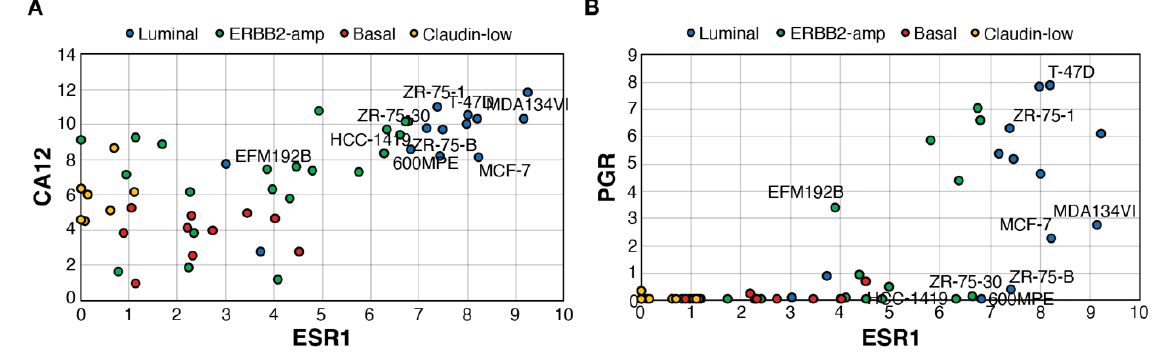
Figure 3. ESR1 high cell lines express high levels of CA12 , but variable levels of PGR . Pair-wise scatterplots for the expression of ESR1 vs those of CA12 ( A ) or PGR ( B ). Values are Log2(Rpkm+1). RNA levels and cell line subtyping are from [61] . Selected cell lines are labeled.